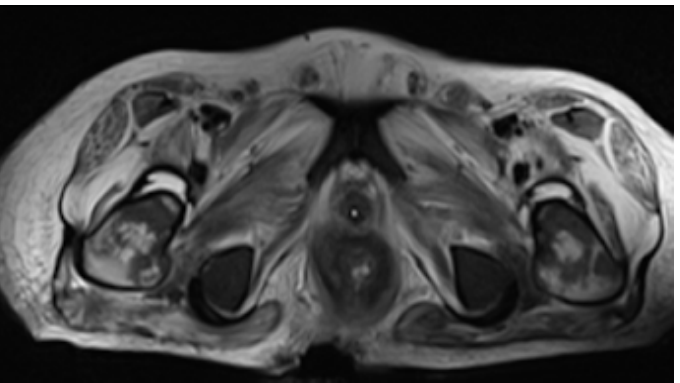
Figure 5. Pelvic MRI demonstrating deep gluteal-sacral soft tissues lesion causing severe barrier loss of integrity with rectal exposure.